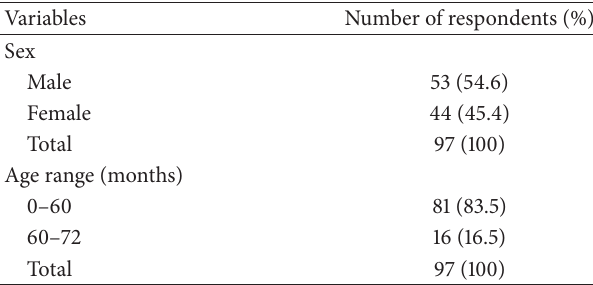
Table 1: Demographic characteristic of the surveyed preschool aged children.